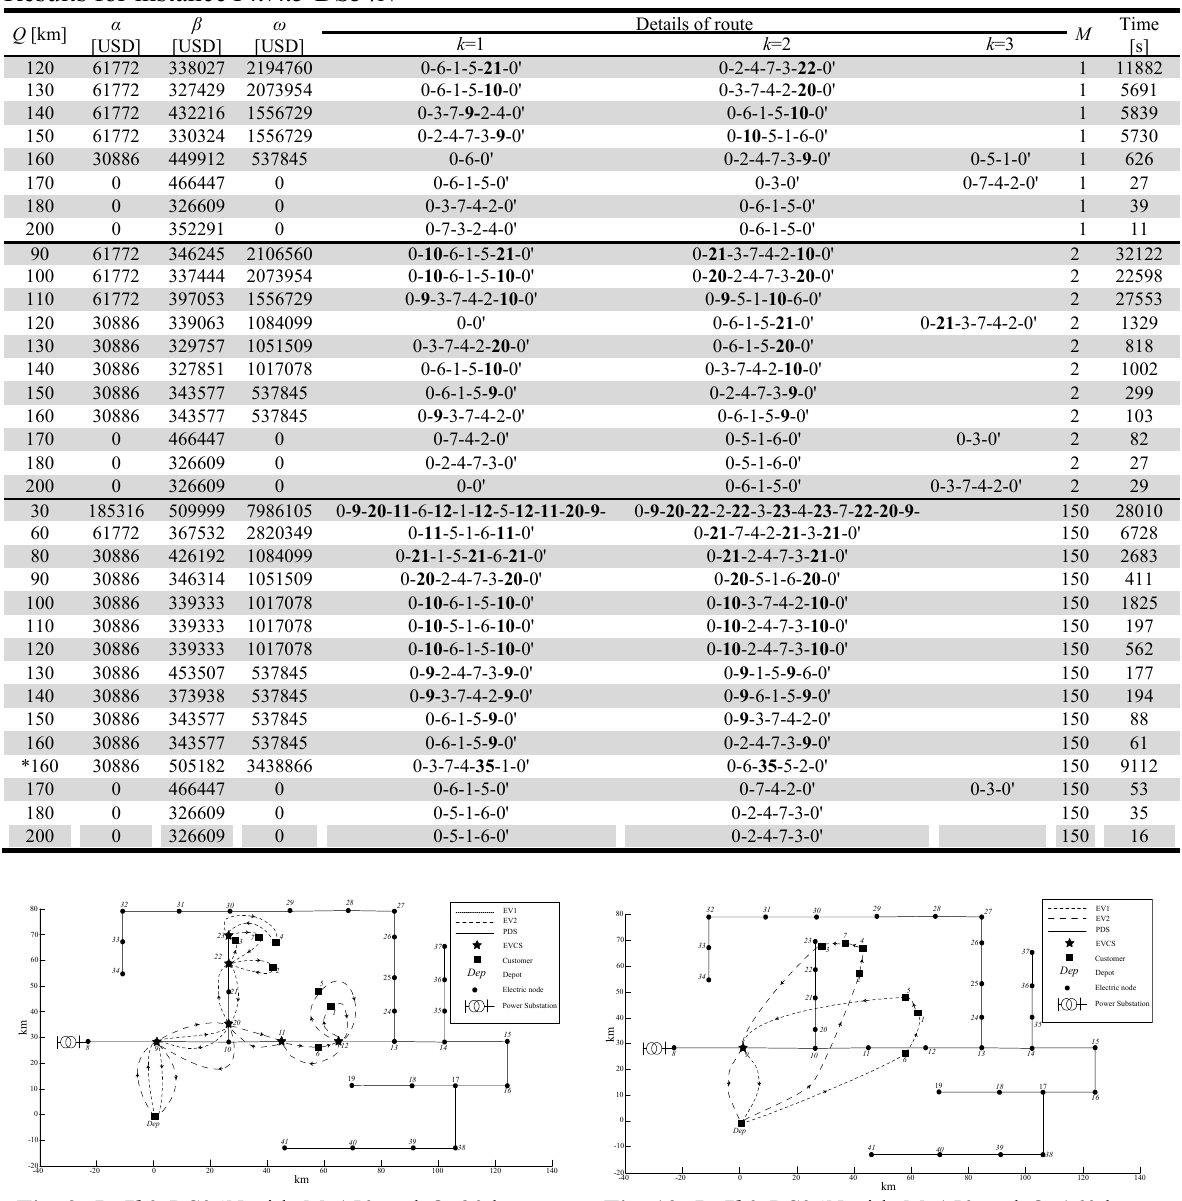
Results for instance Pn7k3-DS34N